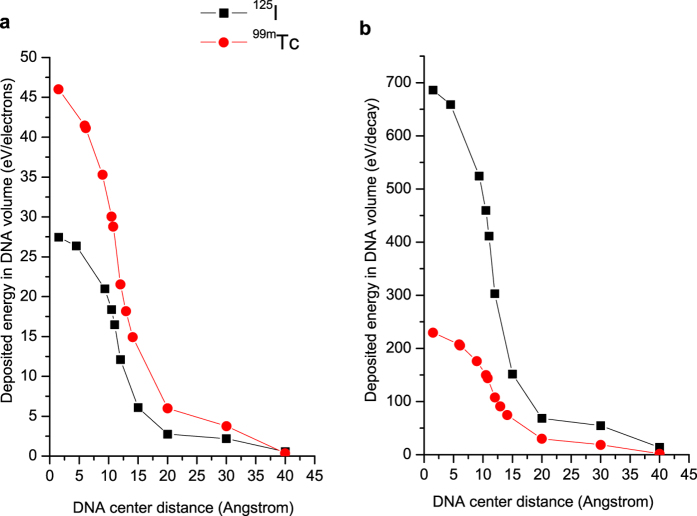
Deposited energies in the DNA segment with the decay sources (125I and 99mTc) at different distances from the DNA center: (a) deposited energies per Auger electron emitted; (b) deposited energies normalized per decay.